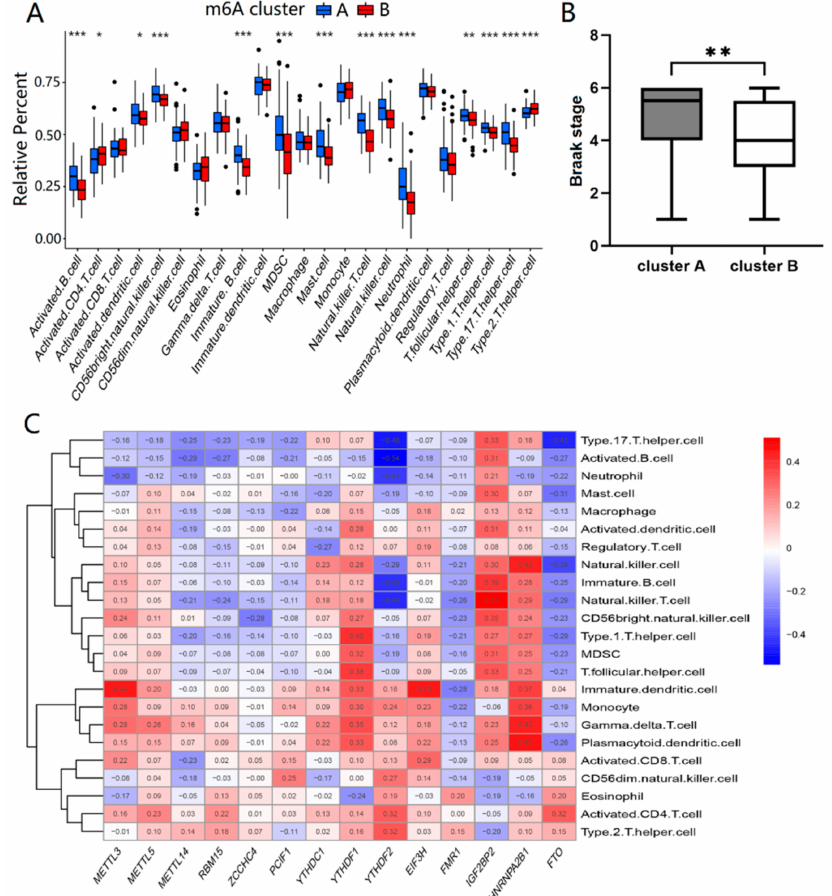
Figure 3. Immune infiltration and Braak staging of two different m6A patterns. ( A ) The t -test was performed to analyze the differential immune infiltrating cells between cluster A and cluster